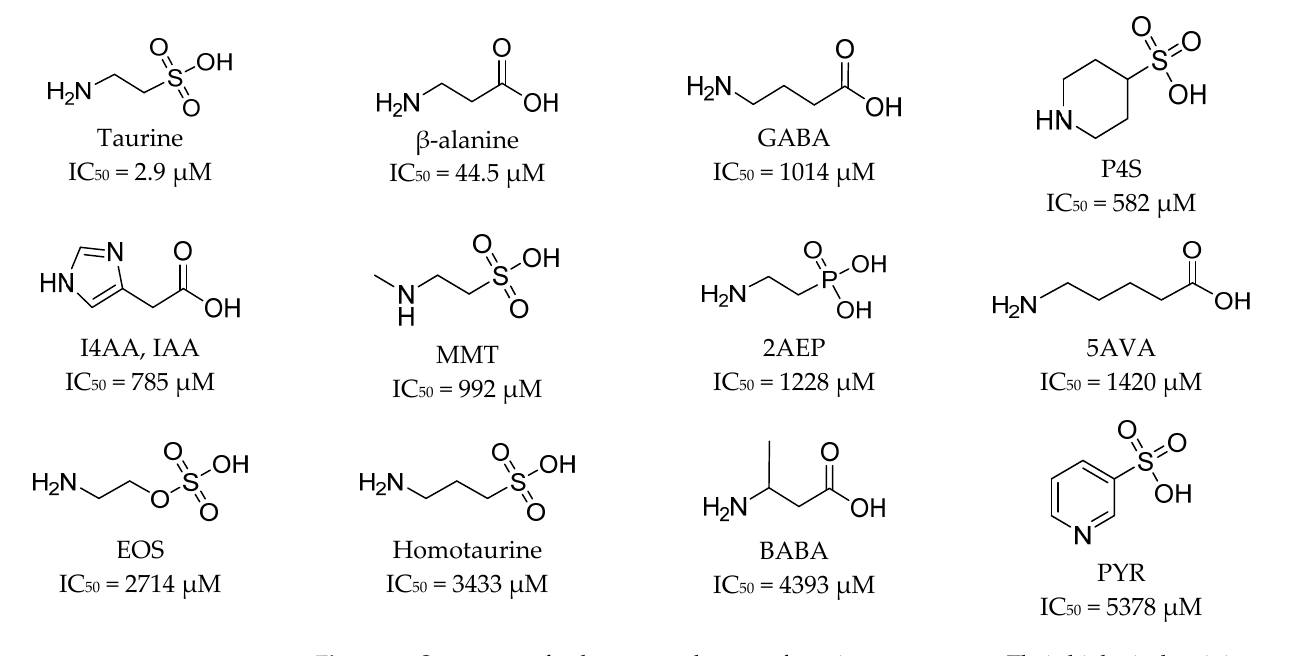
Figure 2. Structures of substrate analogues of taurine transporter. Their biological activity was determined by [ 3 H]-taurine uptake using HEK293 cells producing TauT-GFP (green fluorescent protein) and expressed as IC 50 values [66].